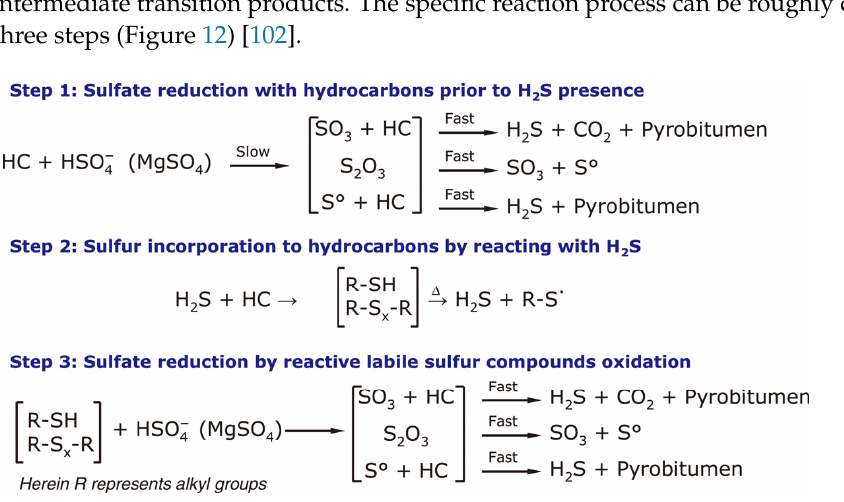
Figure 12. TSR reaction mechanism (after [102]).